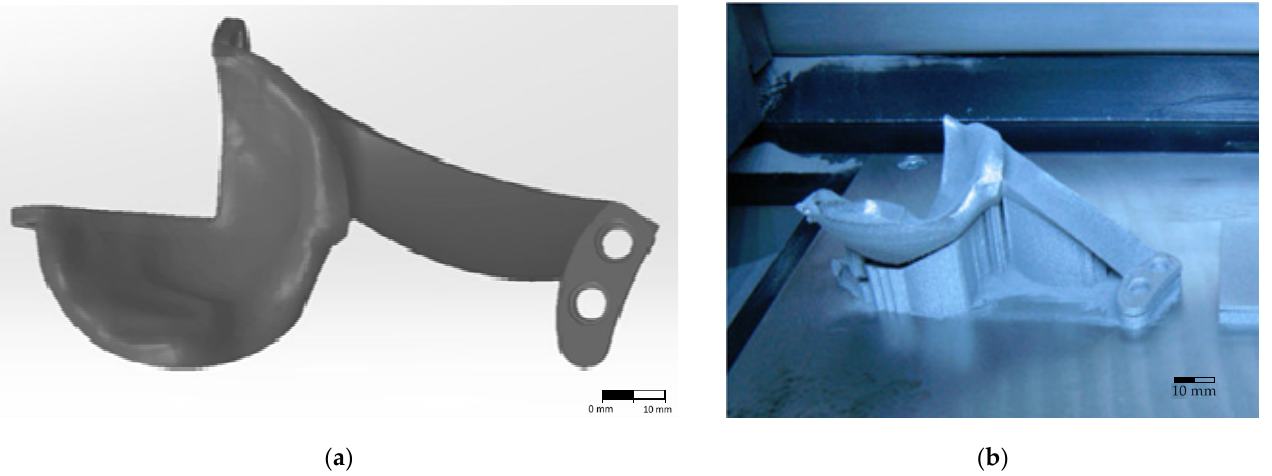
Figure 2. Custom hip implant model ( a ) custom 3D model ( b ) model resulted from the DMLS additive manufacturing process. Table 3. Working parameters of the EOS M270.